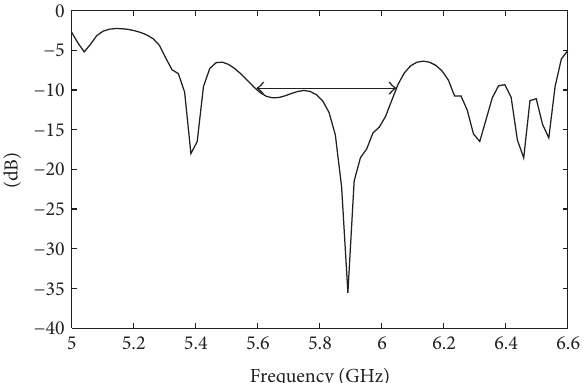
Figure 3: Simulated return loss of the antenna array. Bandwidth for 𝑆11 < − 10dB is